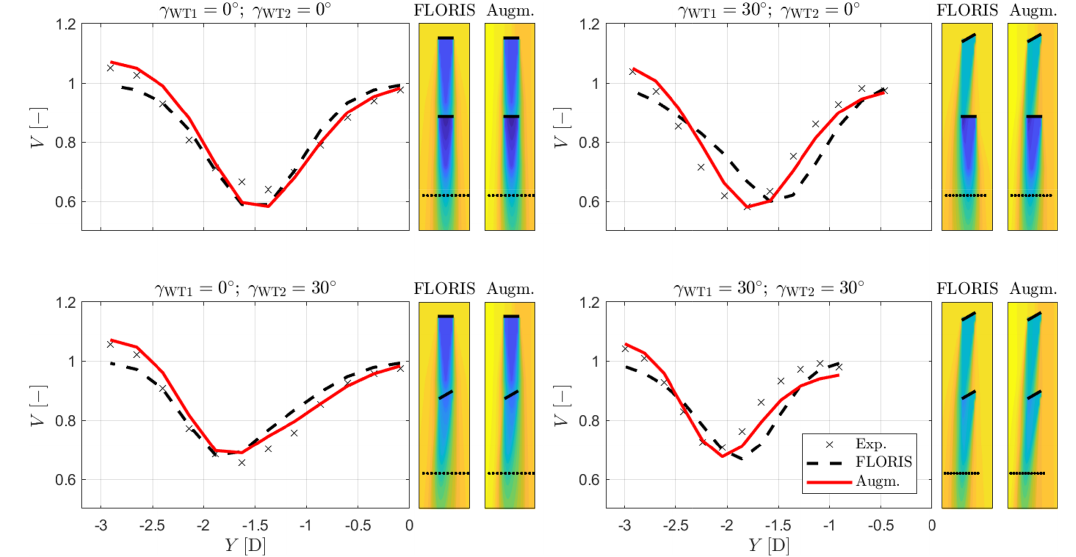
Figure 9. Wake profiles 5 D behind WT2 for various combinations of turbine yaw misalignment. Experimental values are indicated by the × symbols. Each subplot is accompanied by two flow visualizations based on the FLORIS model and its augmented version.